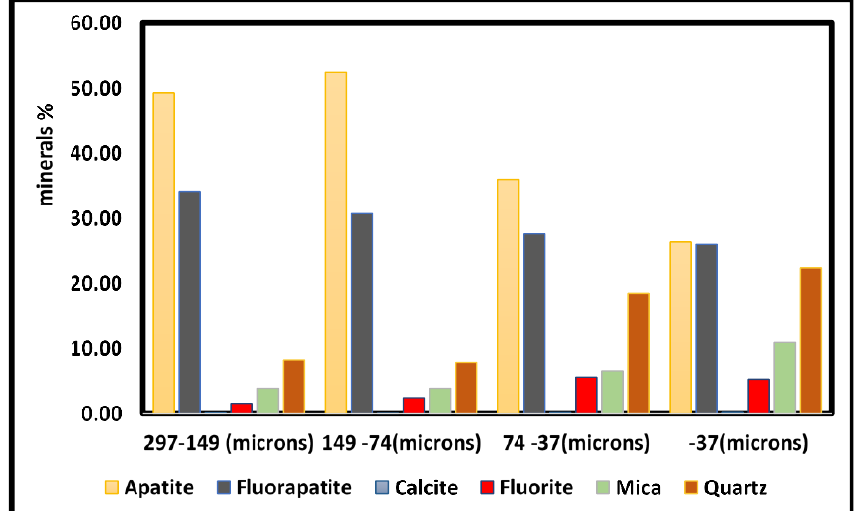
Figure 2. Distribution of minerals in different size fractions of the tailing samples as determined by MLA.